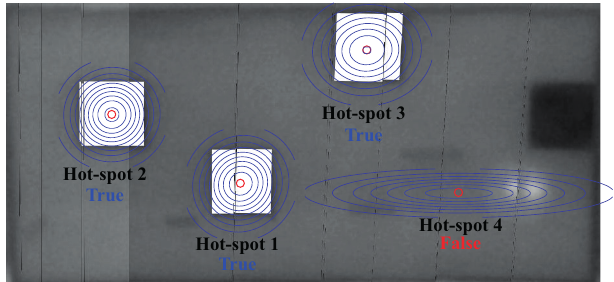
Figure 12. Results of the hot-spot detection: The system searches five hot-spots over the analyzed photovoltaic module.